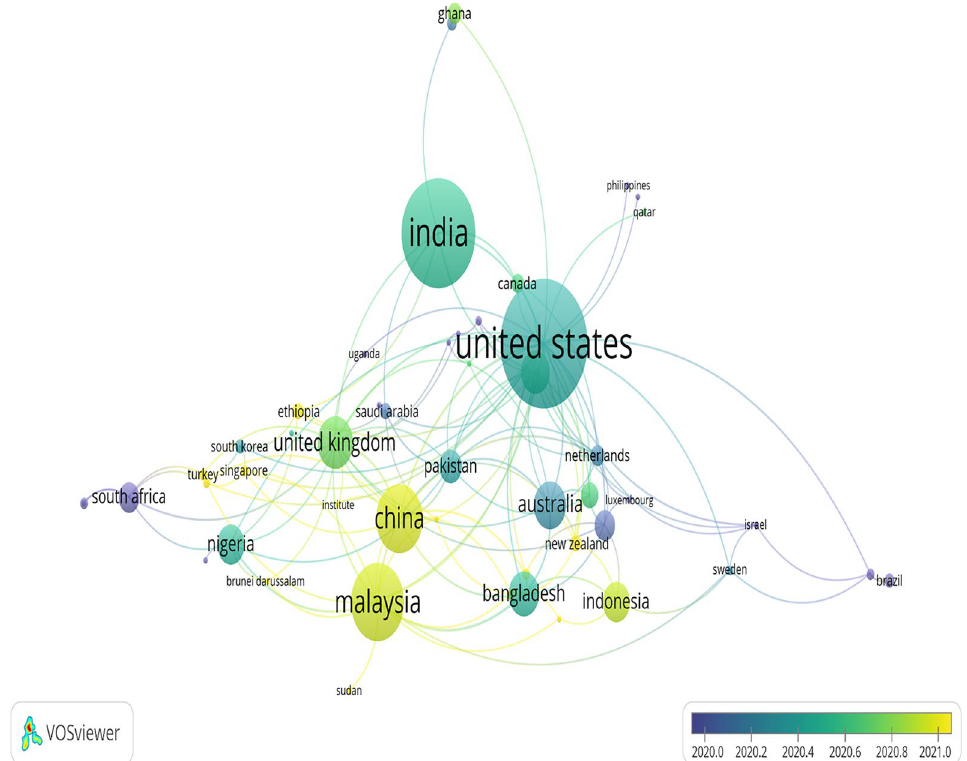
Fig. 2 The author co-authorship network. The whole network consists of 51 nodes, 10 clusters, and 141 links. The total link strength value is 202